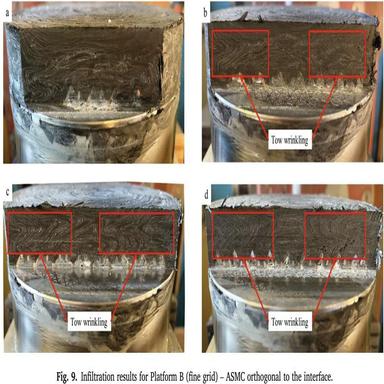
Summary of mechanical properties of the hybrid joints in the different tested configurations; 10a) Maximum Load; 10b) pullout failure energy.